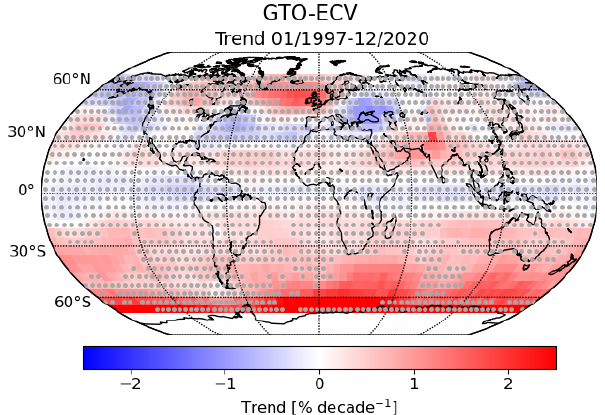
Figure 3. Total ozone trend for 1997–2020 (in % per decade) de- rived from the GTO-ECV data record. Grey dots signify that the trend is statistically not significant at the 2 σ uncertainty